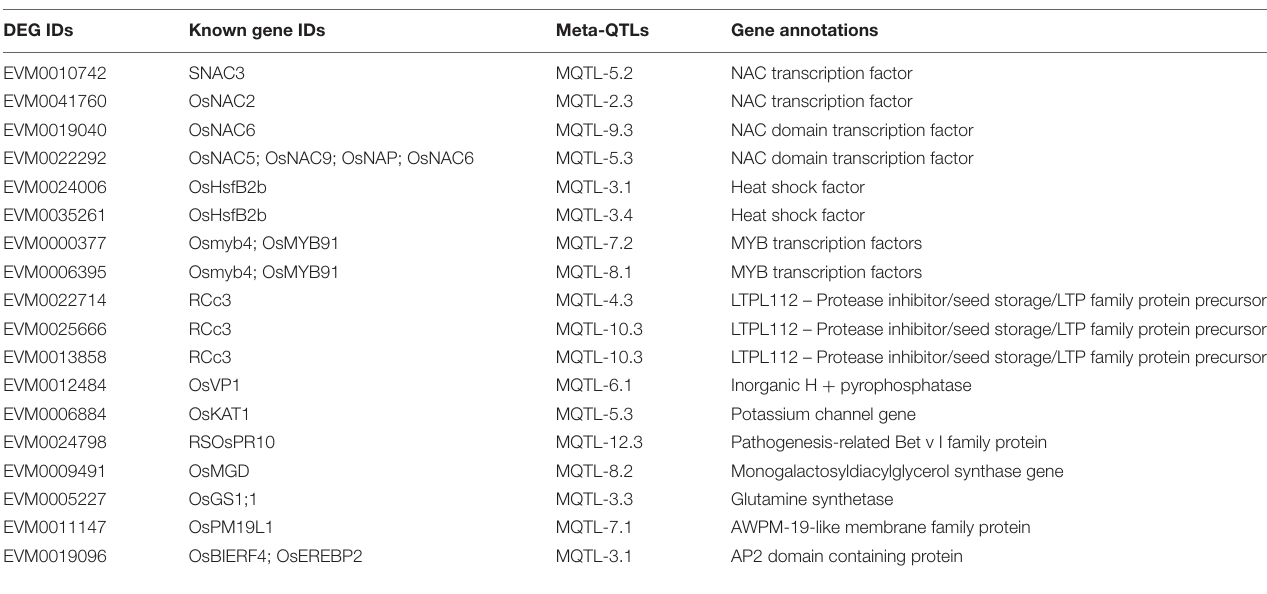
TABLE 1 | Eighteen homologous genes of known